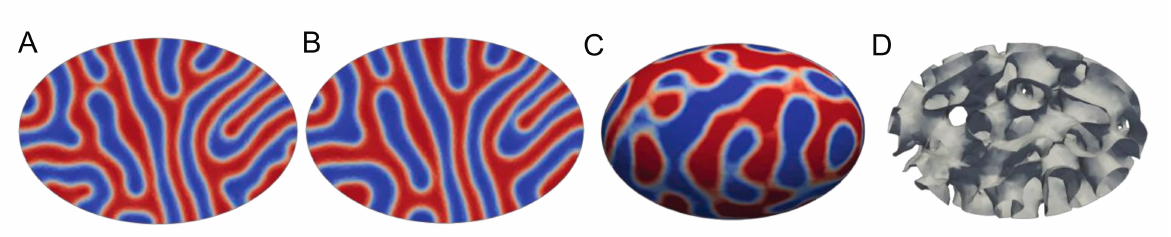
Figure 8. Calcium-free mitochondrial ultrastructure simulation for 2D ellipse and 3D ellipsoid domains. The time step ∆ t = 0.005 for ( A ) t 800 , ( B ) t 1000 , ( C ) t 60 , and ( D ) the inside contour of ( C ). The boundary domain did not strongly regulate the inner membrane